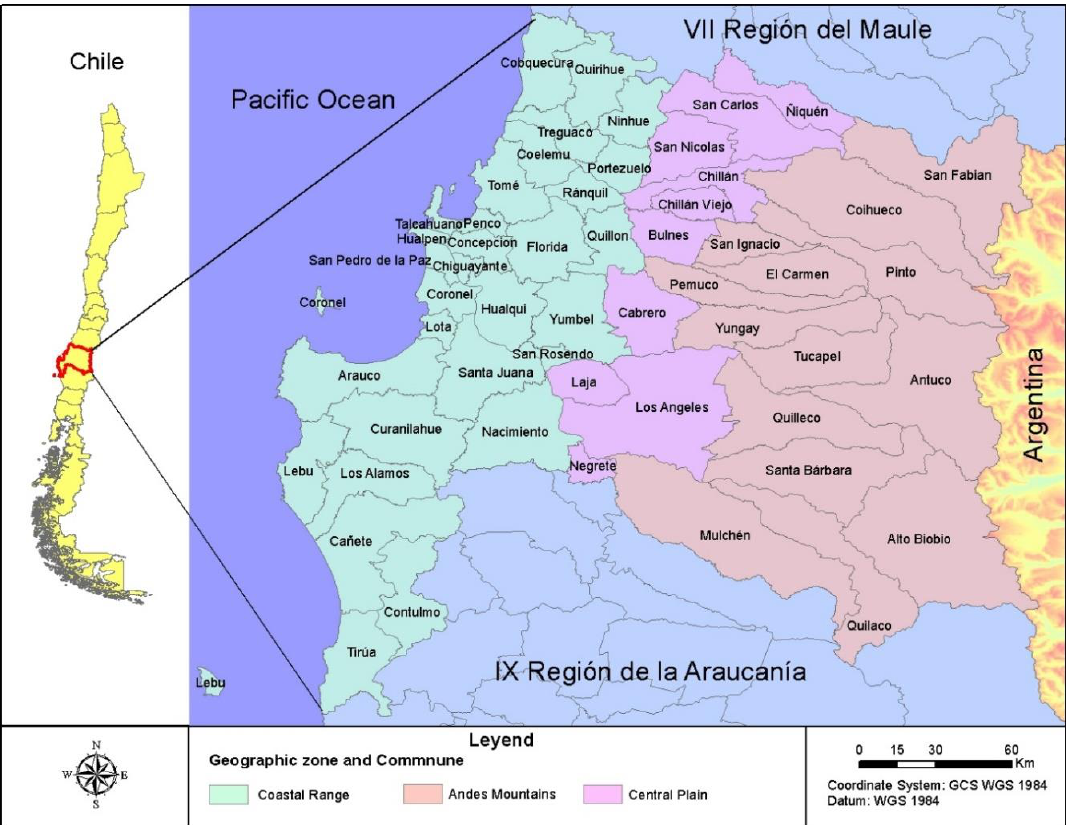
Figure 1. Study area and geographic zones and communes.